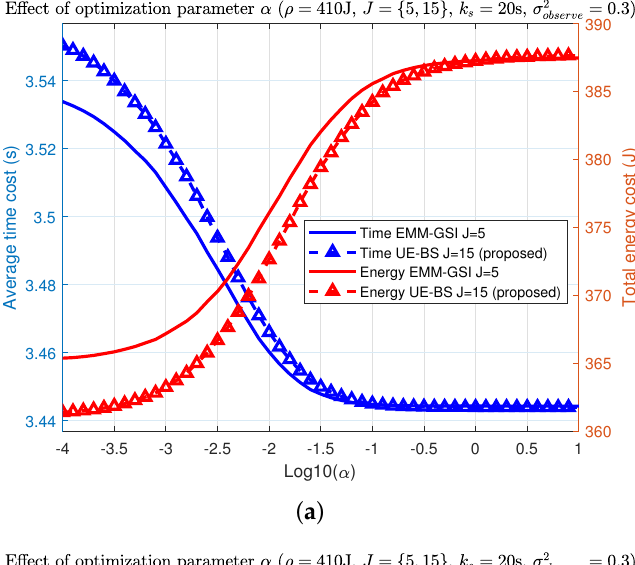
Figure 5. Effect of optimization parameter α ( ρ = 410 J, J = { 5,15 } , k s = 20 s, σ 2 ( a ) online UE-BS algorithm; ( b ) online BS-learning